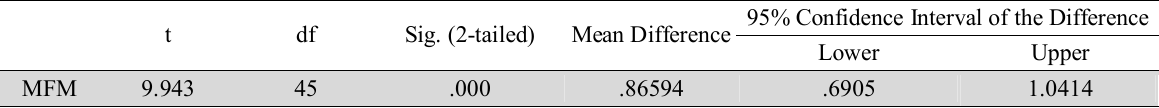
The summary of testing the effect of information technology on marketing and financial management (Test value =